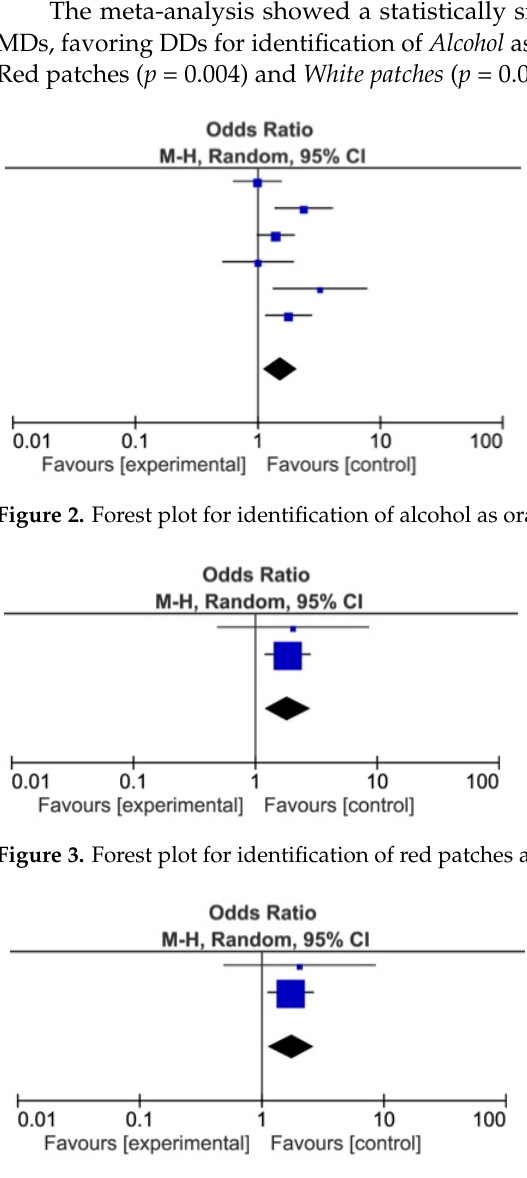
Figure 4. Forest plot for identification of white patches among DDs and